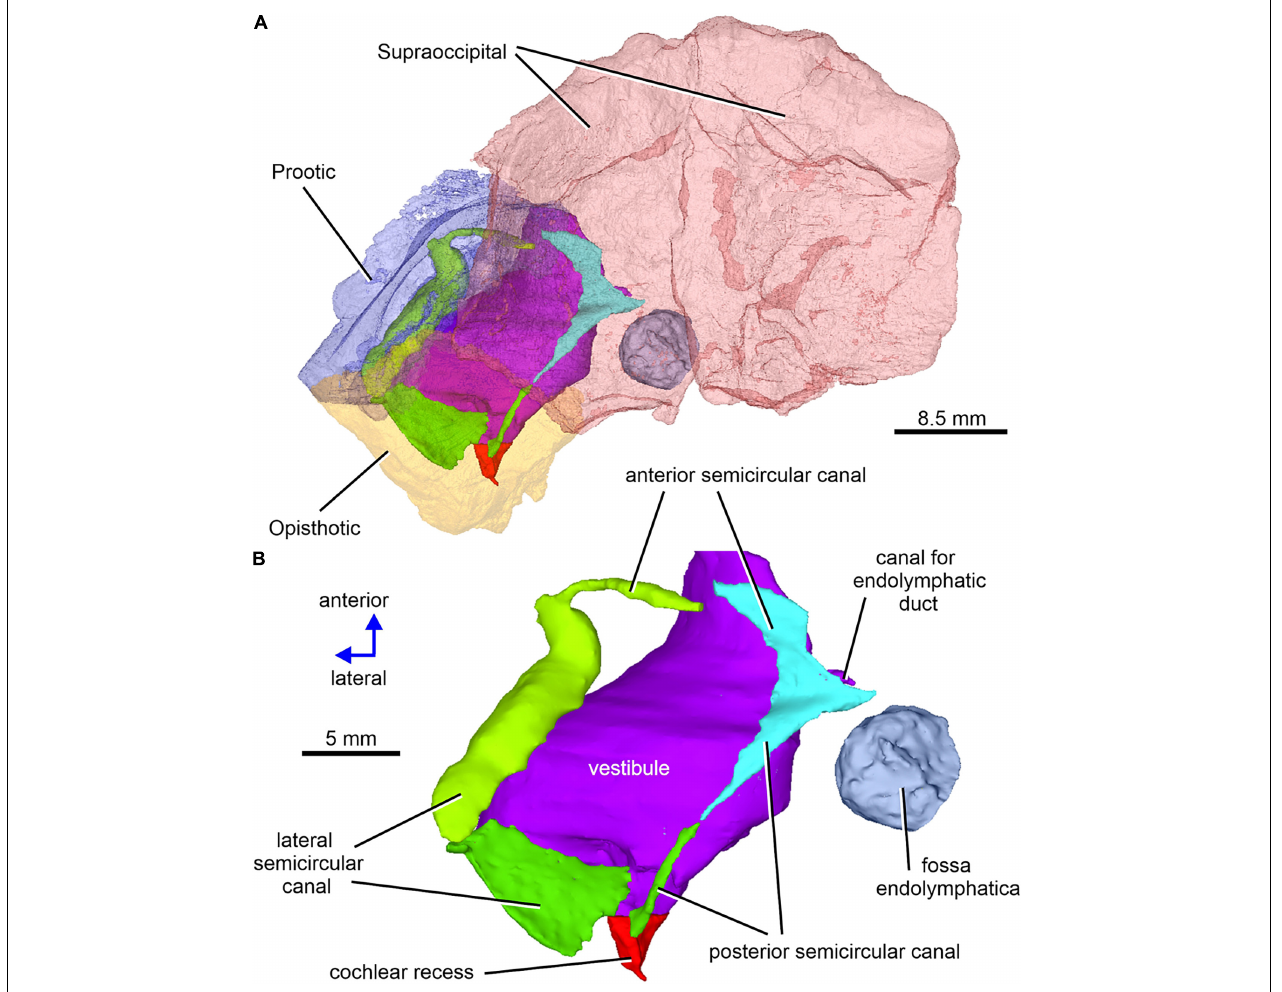
FIGURE 12 | Limnoscelis dynatis , CM 47653. (A) Left semitransparent prootic, opisthotic and both supraoccipitals to see the position of inner ear structures. (B) Virtual 3D model of the inner ear in dorsal